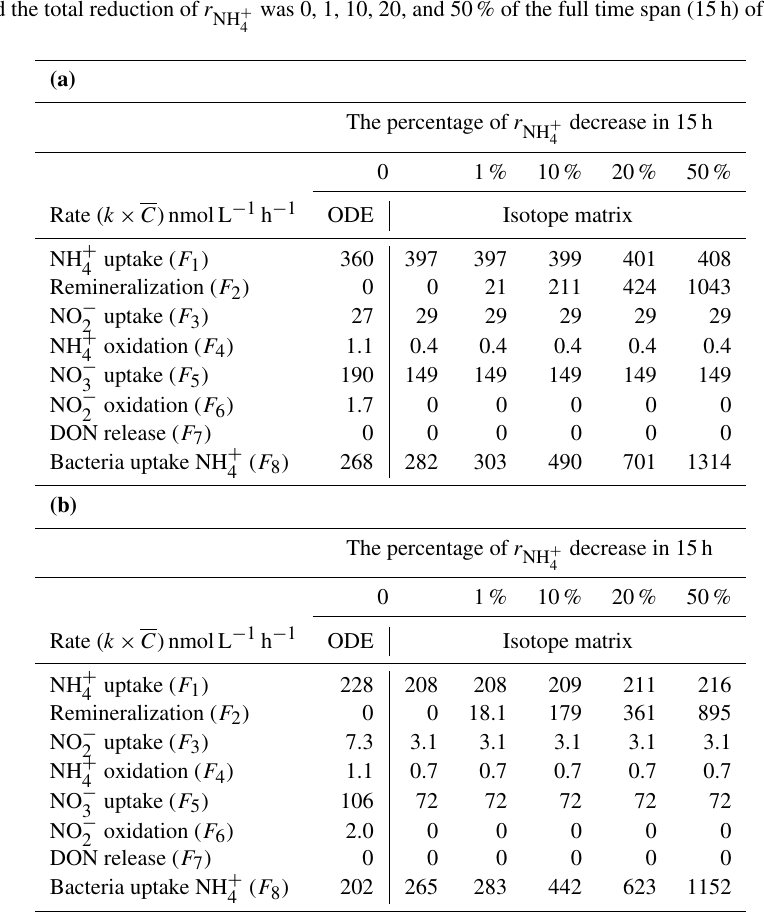
values at a NH + 4